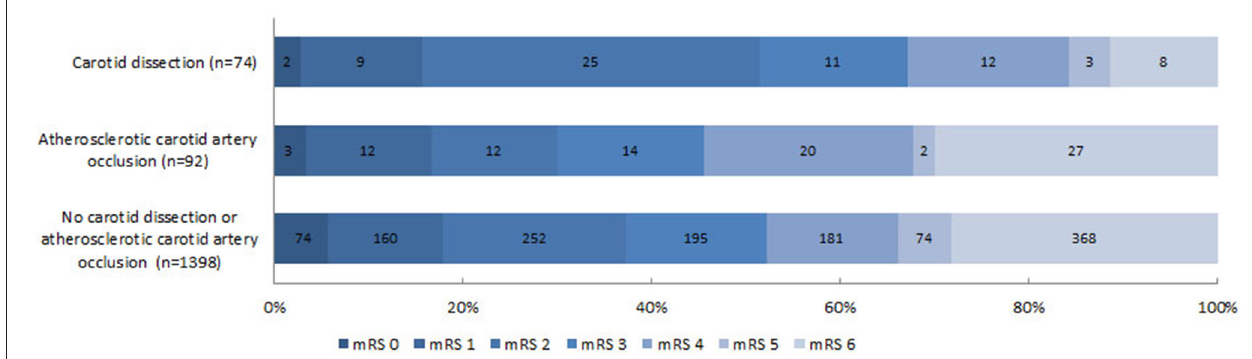
Patients without CAD or ACAO ( n = 1398)